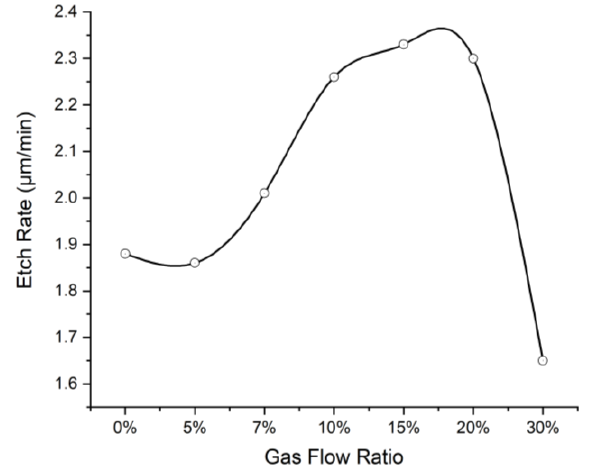
Figure 4. The relationship between etch rate and gas composition under 2500 W ICP power, 500 W RF power, and 100 sccm etch gas flow speed.